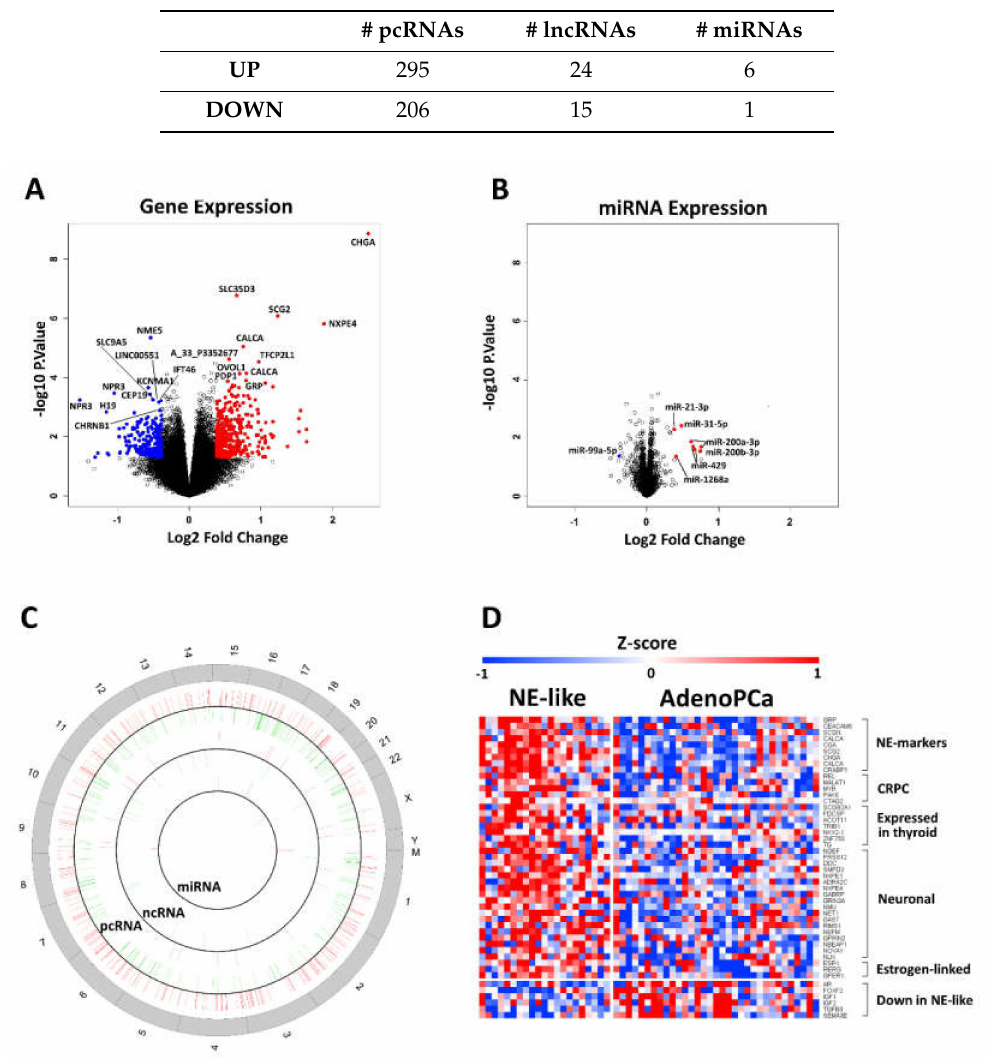
Table 2. The number (#) of di ff erentially expressed pcRNAs, ncRNAs and miRNAs in NE-like vs. AdenoPCa samples.